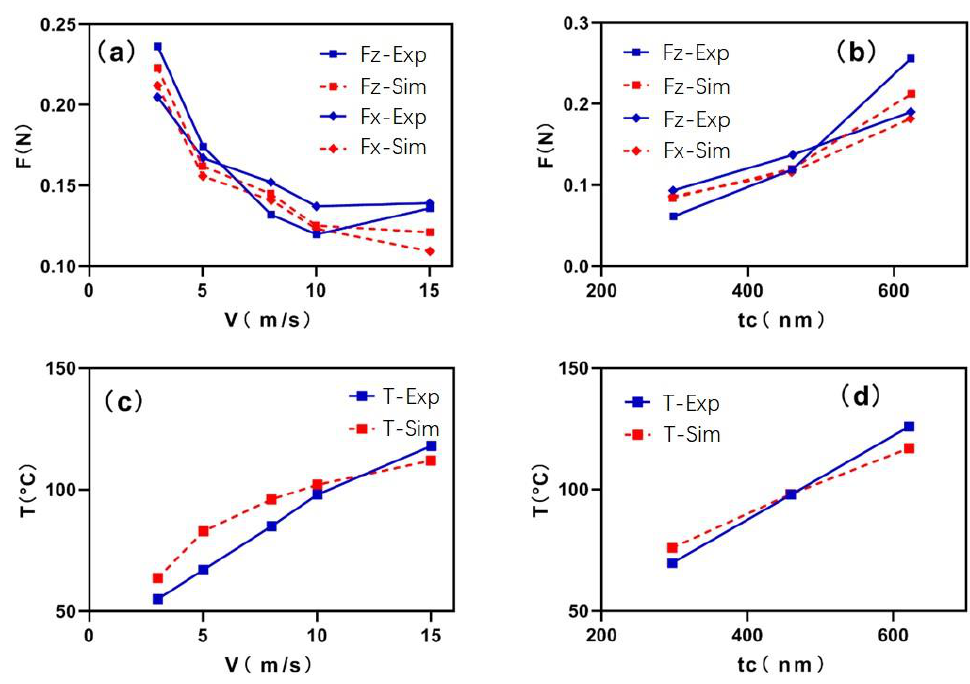
Figure 6. Variation of cutting force and temperature under different cutting conditions. ( a ) Comparison of cutting forces at different cutting speeds under the same unformed chip thickness of 429 nm. ( b ) The comparison of cutting forces at different unformed chip thicknesses under the cutting speed of 10 m/s. ( c ) Comparison of cutting temperatures at different cutting speeds and unformed chip thickness of 429 nm. ( d ) Comparison of cutting temperature at different cutting and depth cutting speed of 10 m/s.